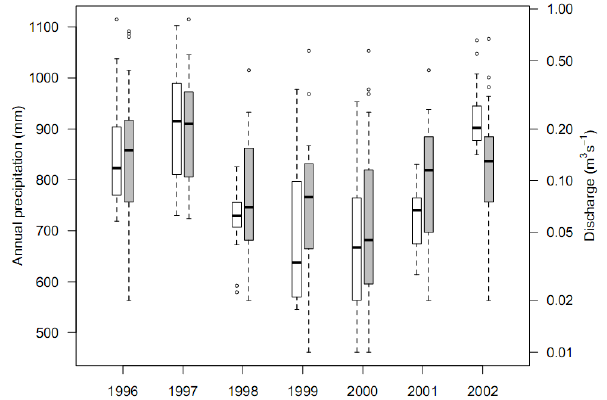
Fig. 2. Annual precipitation (white) and mean annual discharge estimated by the Sacramento hydrological model for the 28 sub- catchments (grey) between 1996 and 2002 in La Tordera basin. Source: ACA